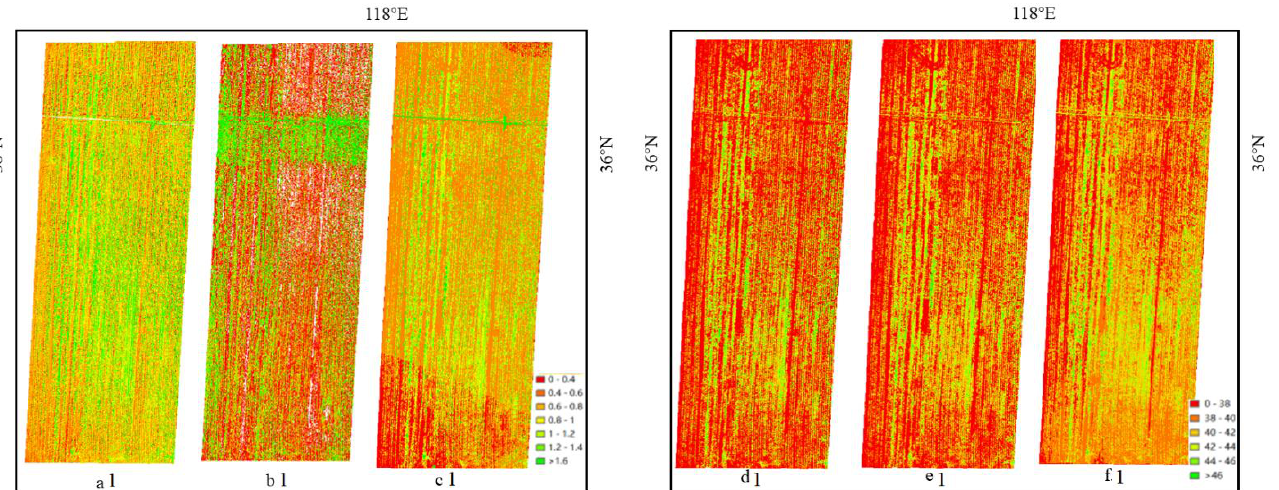
Figure 5. The inversion diagram of each model in the trumpet period, tasseling period and blistering period in 2021. ( a1 ), ( a2 ) , ( a3 ) MLR model; ( b1 ), ( b2 ), ( b3 ) PLSR model; ( c1 ), ( c2 ), ( c3 ) RF model; ( d1 ), ( d2 ), ( d3 ) MLR model; ( e1 ), ( e2 ), ( e3 ) PLSR model; ( f1 ), ( f2 ), ( f3 ) RF model. ( a – c ) is the inversion model of LAI; ( d – f ) is the inversion model of SPAD. ( a1 )~( f1 ) is the inversion diagram in the trumpet period. ( a2 )~( f2 ) is the inversion diagram in the tasseling period. ( a3 )~( f3 ) is the inversion diagram in the blistering period.